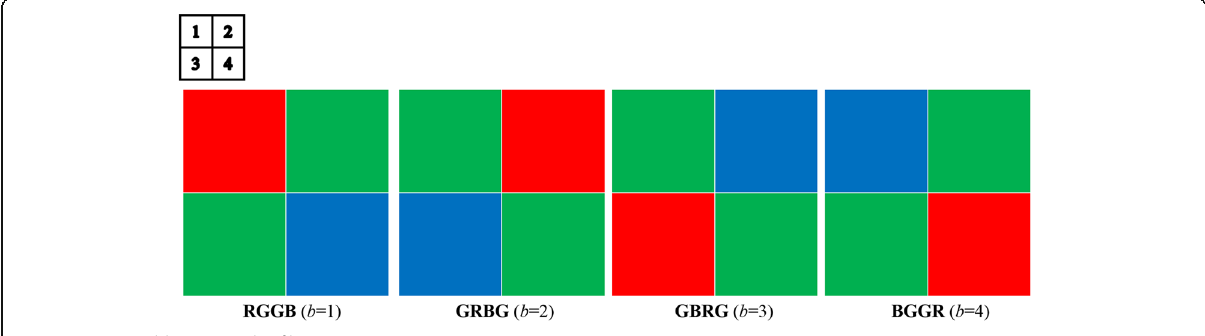
Fig. 1 Four possible Bayer color filter